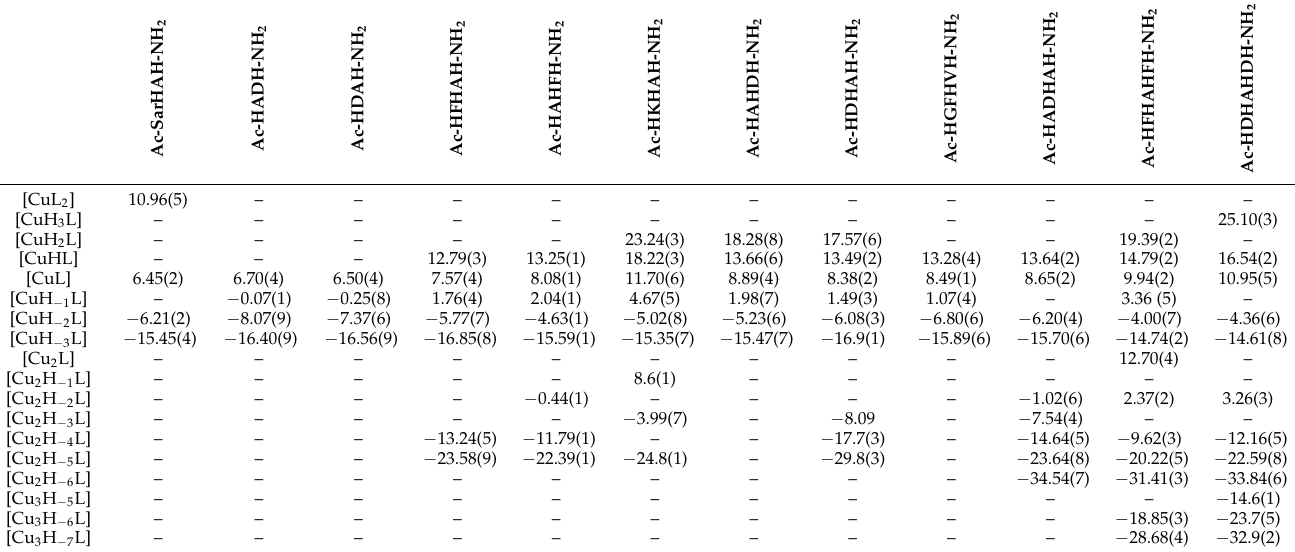
Table 1. Stability constants (log β ) of complexes formed in the different Cu(II)-multihistidine peptide systems (T = 298 K, I = 0.2 M KCl).